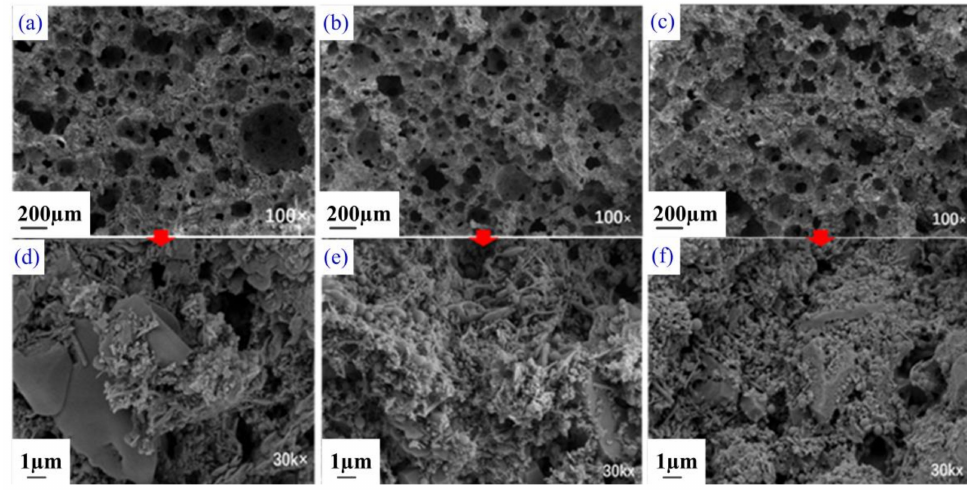
Figure 7. Microscopic examination of the sample: ( a , d ) blank group; ( b , e ) foam stabilizer content 0.2%; ( c , f ) water-proofing agent content